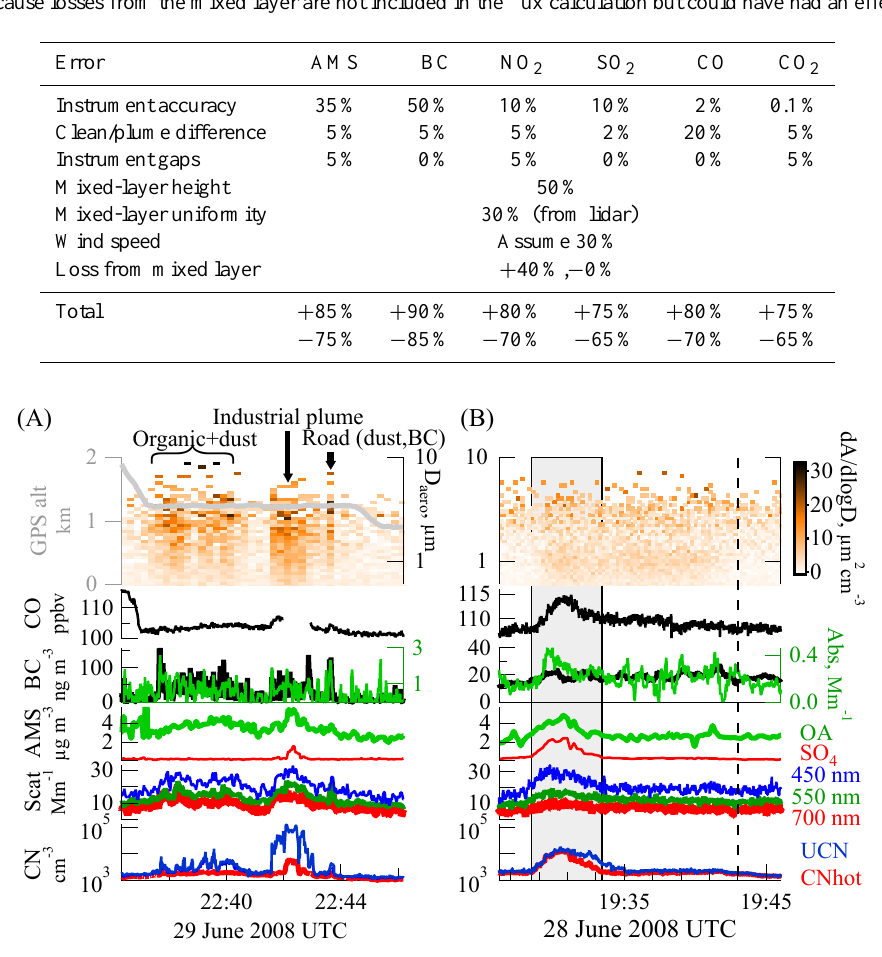
Figure 10. P-3B crossings of the oil sands plume at (A) about 10km (on 29 June) and (B) about 180km (28 June) from the upgraders. Vertical scales are the same on both plots except for CO, BC, and absorption. Absorption is for 530nm light. The gap in CO data around 22:42 on 29 June was due to an automatic calibration cycle. Altitude on 28 June was constant at 1200m, so it is not shown. Low BC and absorption rendered the data sufficiently noisy that a 21s box filter was applied to make changes visible. The gray region shows the minimal plume period used to calculate fluxes in Table 1, defined by the enhanced SO 4 . The vertical dashed line marks the end of the maximum plume period, determined from BC and the 1µm mode visible in the APS data.